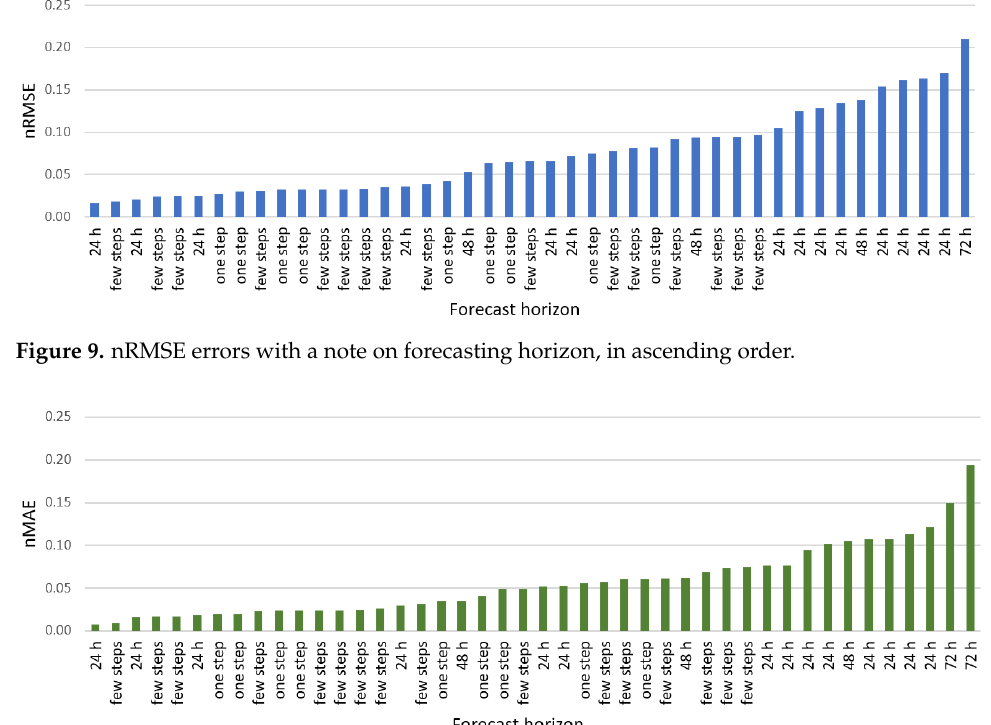
Figure 8. Selected statistics of errors and error quotients.